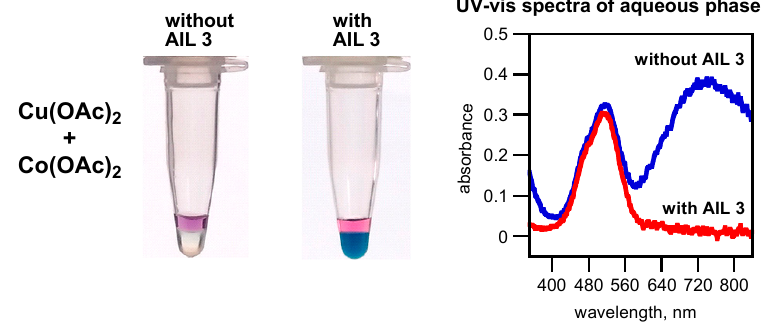
Figure 3. Optical photographic images and UV-vis spectra of affinity extraction of an aqueous solution (10 μ L) containing Cu(OAc) 2 (0.1 M) and Co(OAc) 2 (0.5 M) by AIL 3 (1.0 M) in ionic liquid 2 (10 μ L).